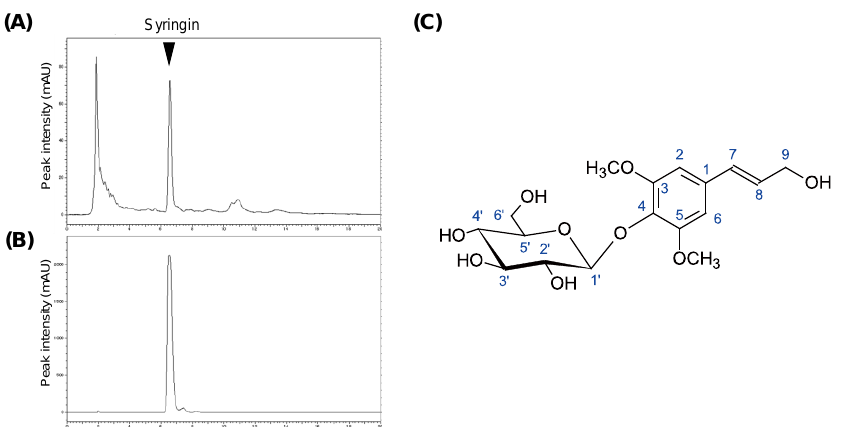
Figure 2. Isolation of active components from CbR and chemical structure identification. ( A , B ) Chromatograms of Fr-1 from crude methanol extract and purified syringin, respectively. ( C ) Chemical structure of syringin revealed by NMR analyses.